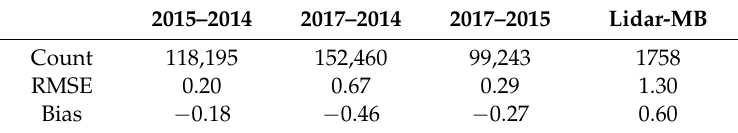
Table 5. RMSE and bias between the CHS surveys for Cambridge Bay.